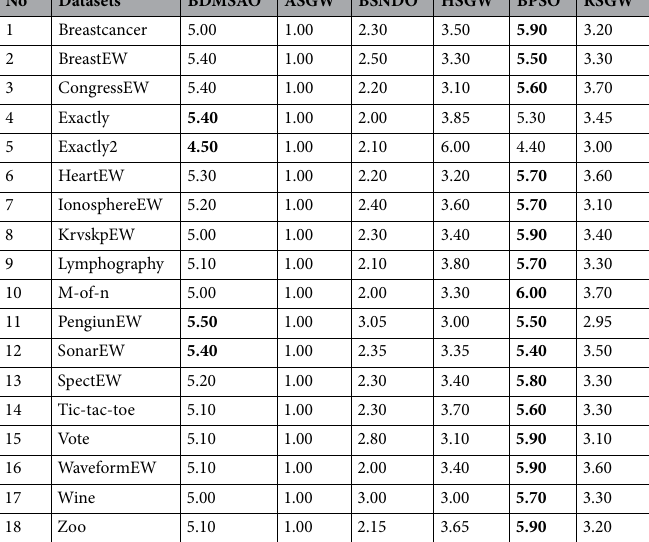
Table 7. Friedman mean ranking